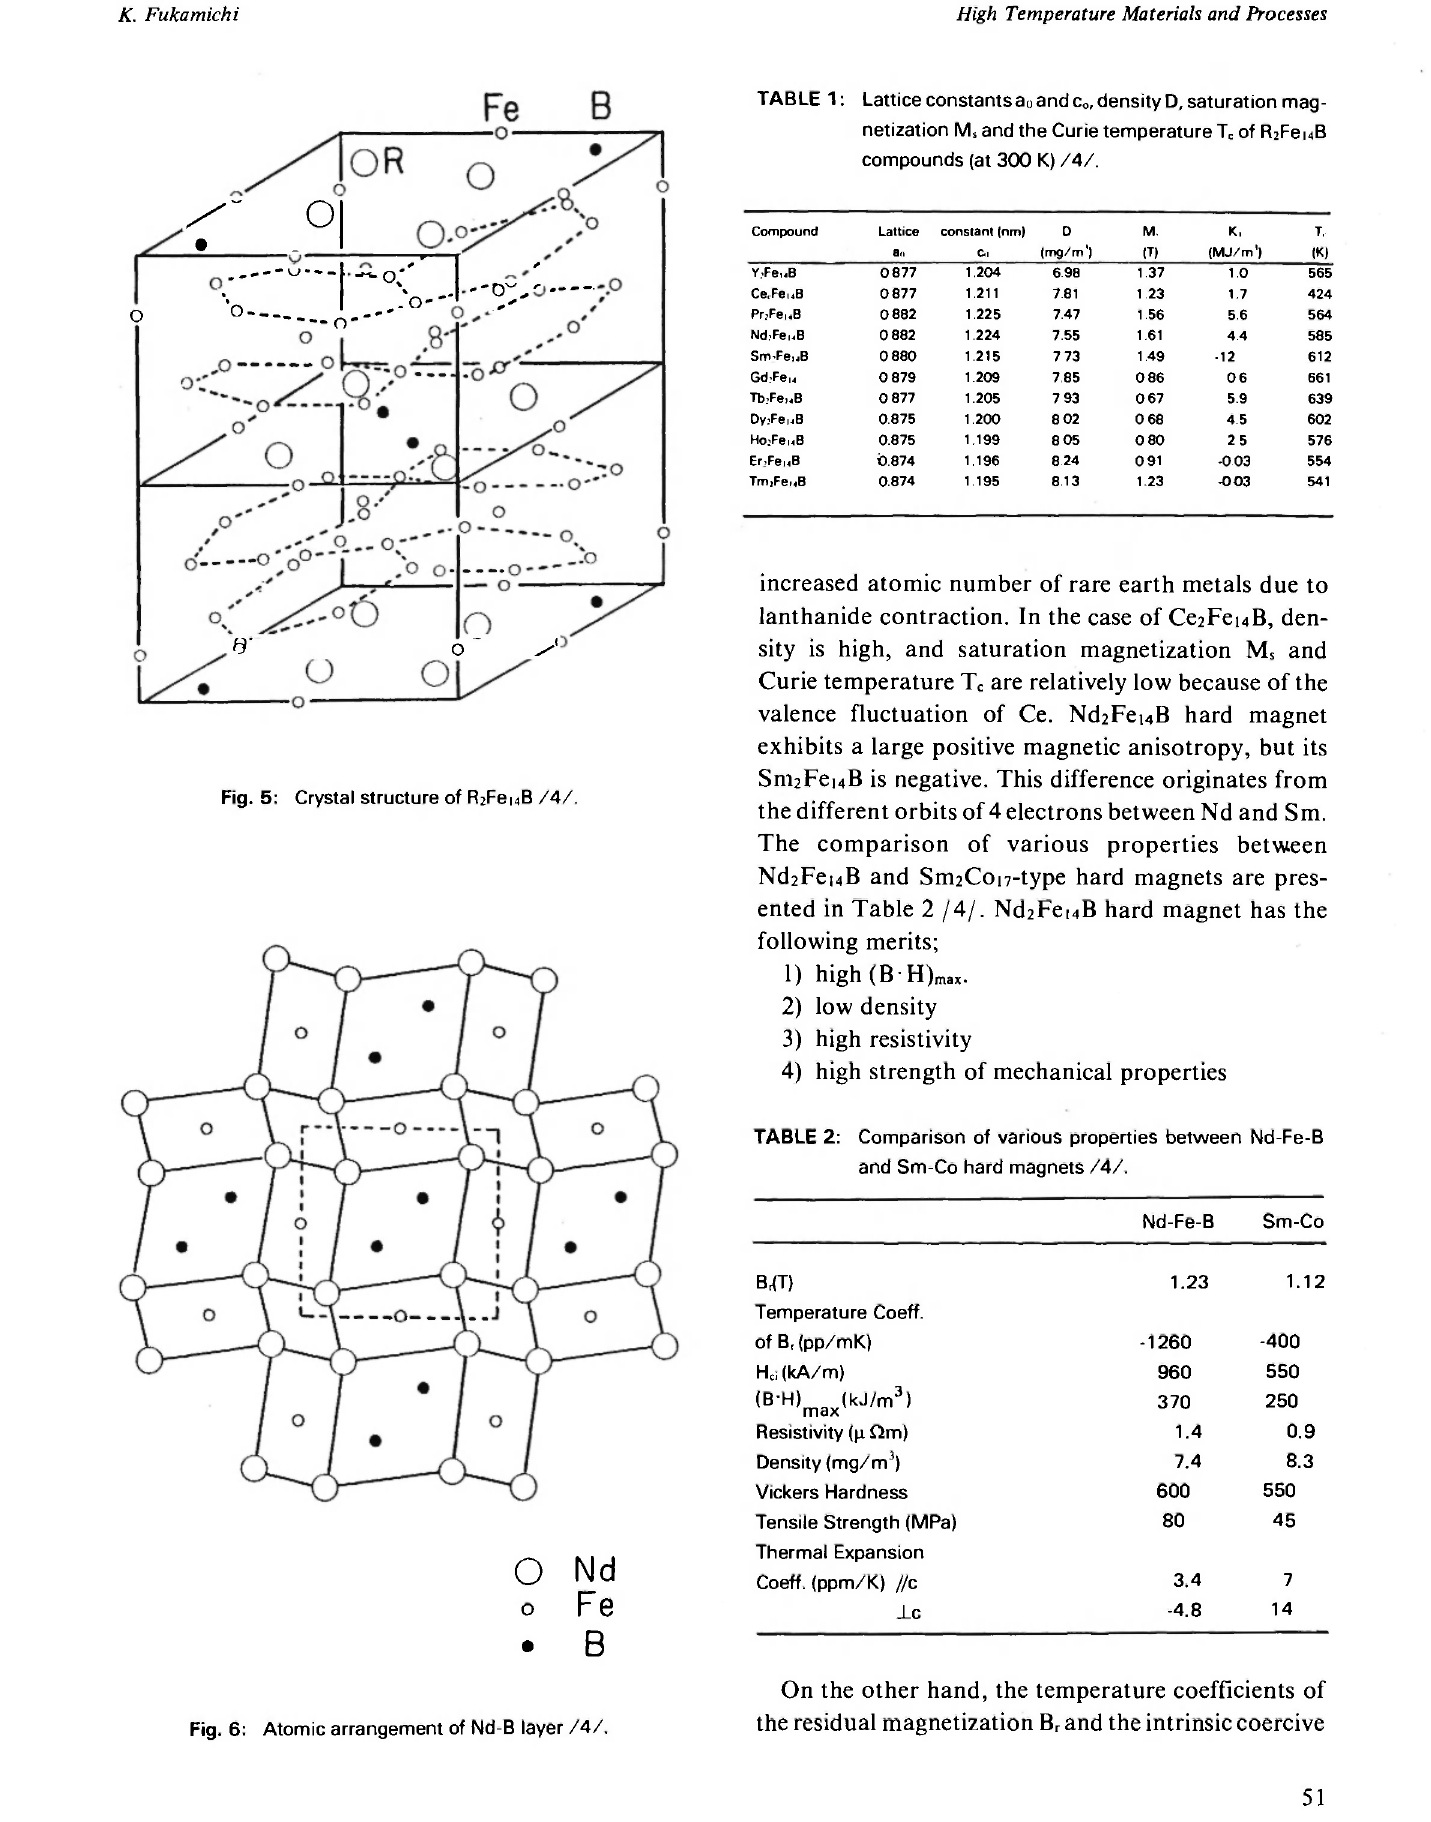
TABLE 1: Lattice constants a 0 and c 0 , density D, saturation mag- netization M s and the Curie temperature T c of R;Fei4B compounds (at 300 K) /4/.